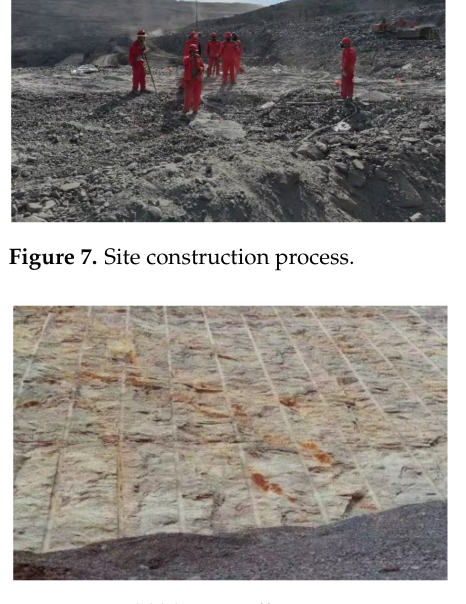
Figure 8. Field blasting